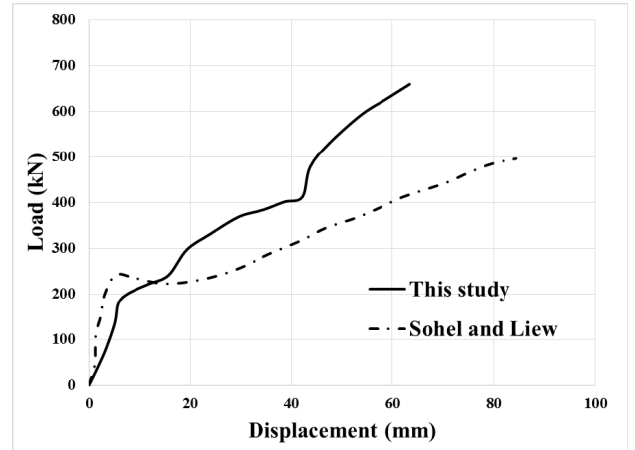
Figure 15. The comparison of the load-displacement curve of SCS slabs with J-hook and CSC connectors with NWC core.